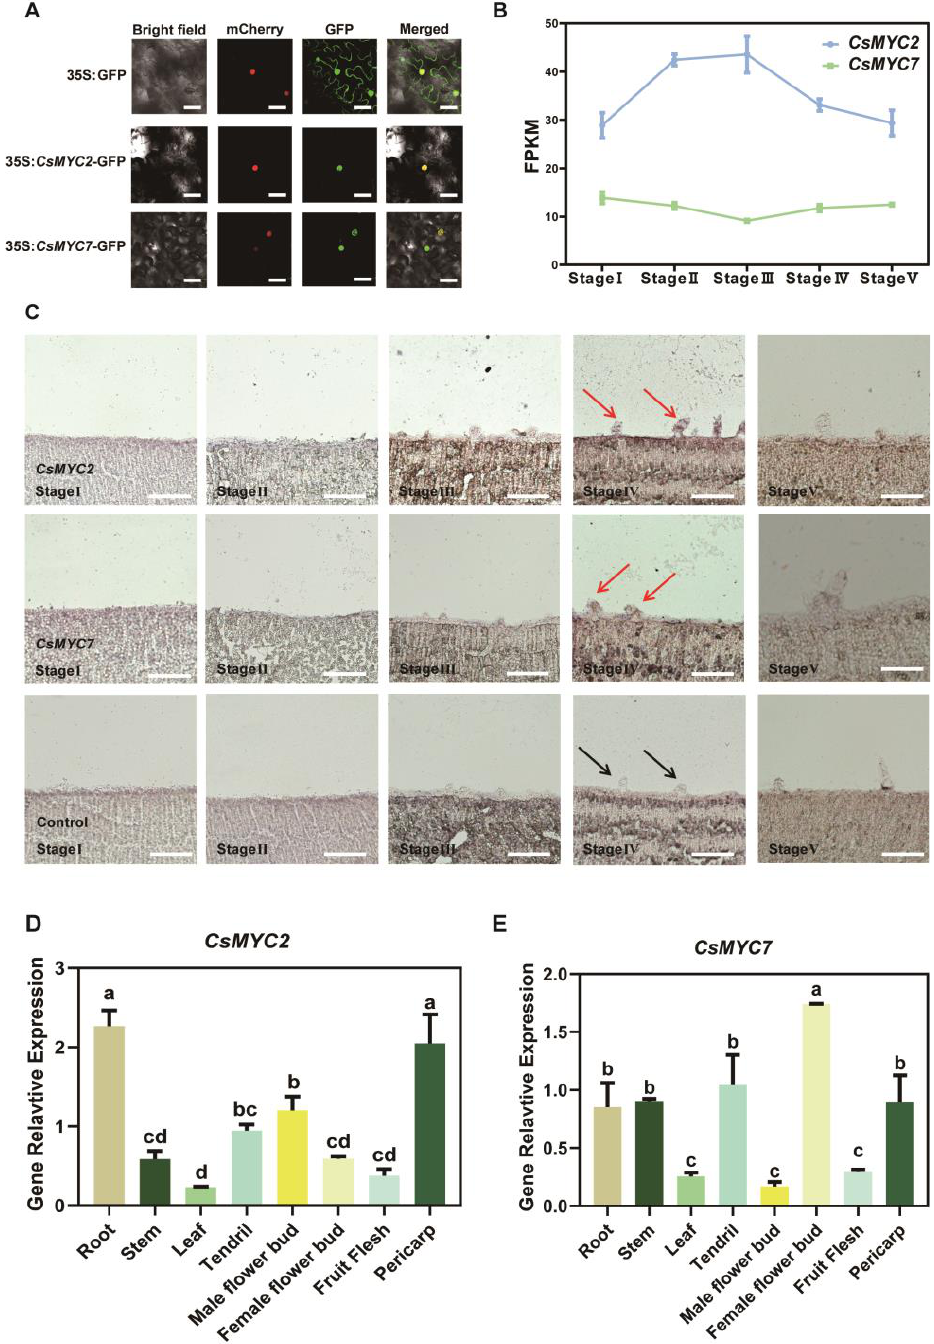
Figure 5. The expression patterns of CsMYC2 and CsMYC7. ( A ) Subcellular localization indicating CsMYC2 and CsMYC7 fusion protein located in the nucleus of N. benthamiana leaves. Empty GFP driven by the super promoter was used as a control. The fluorescent signals of GFP channel indicate GFP position. The fluorescent signals of mCherry channel indicate mCherry-labeled nuclear marker position. Bars represent 50 μm. ( B ) FPKM of CsMYC2 and CsMYC7 from transcriptome data [10]. ( C ) In situ hybridization performed at five glandular trichome developmental stages of CsMYC2 and CsMYC7 in cucumber cotyledon. Black arrow shows cucumber GTs. Red arrow shows the expression of genes in cucumber GTs. Bars represent 1 mm. ( D , E ) Expression analyses of CsMYC2 and CsMYC7 in different cucumber organs. Error bars represent SD from three biological repeats. Different letter indicates statistically significant differences between groups.